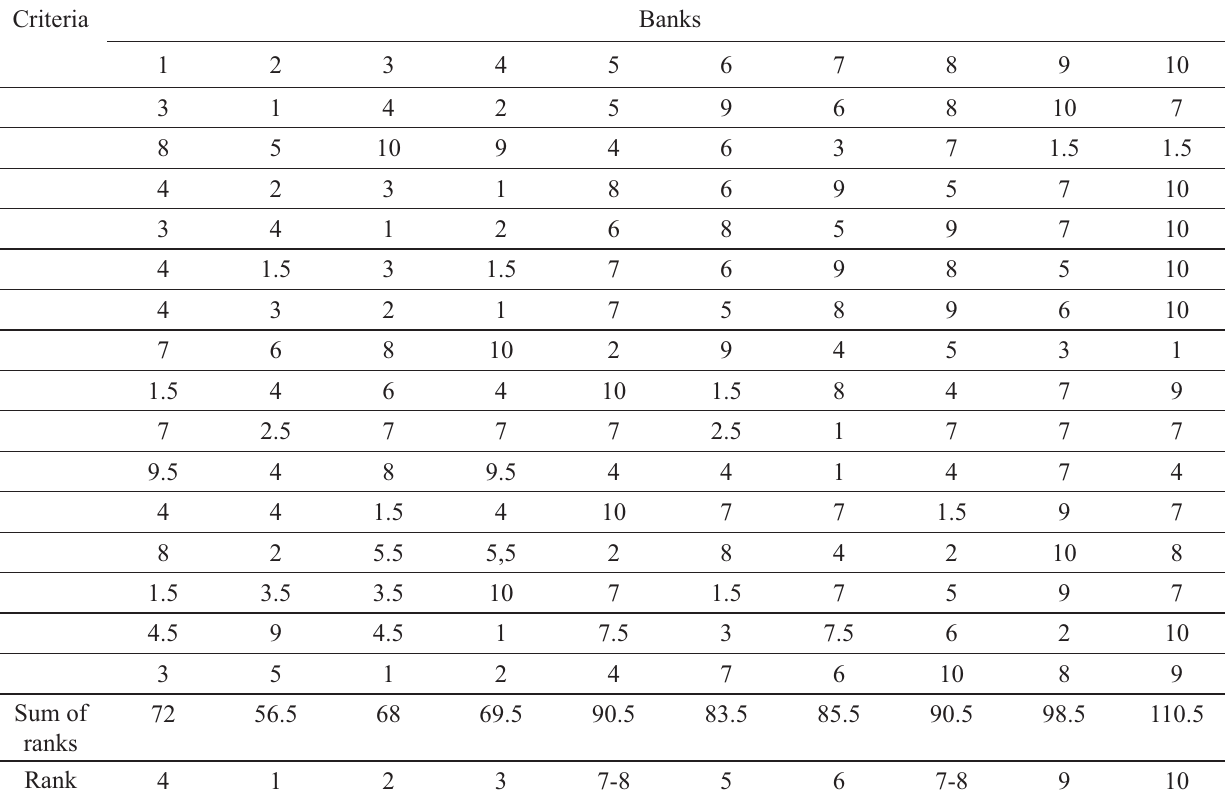
Table 8. The ranks assigned to Lithuanian commercial banks according to their reliability in 2007